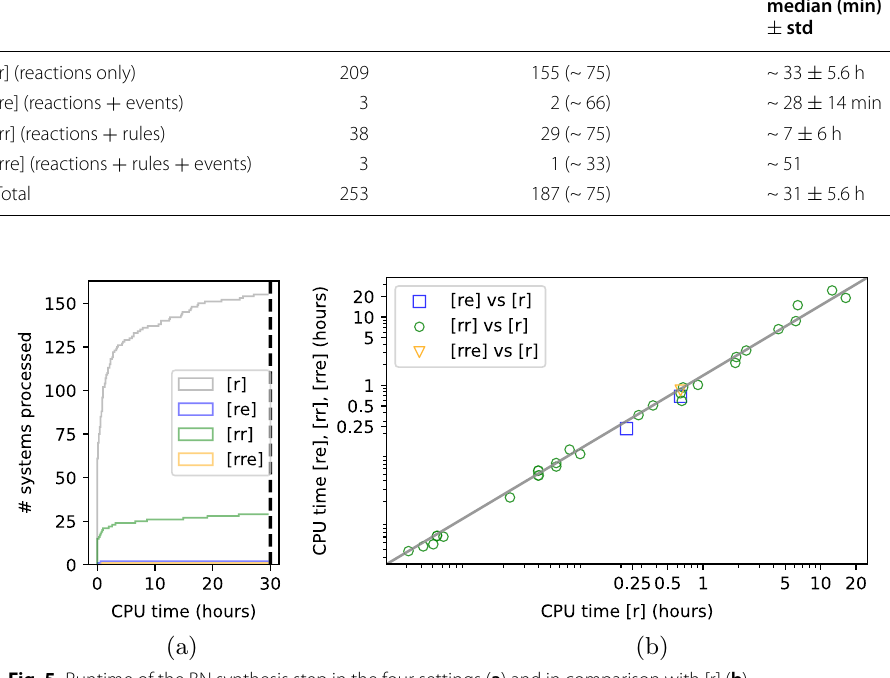
Table 2 Number of models processed and CPU time of the BN synthesis step Setting # to process